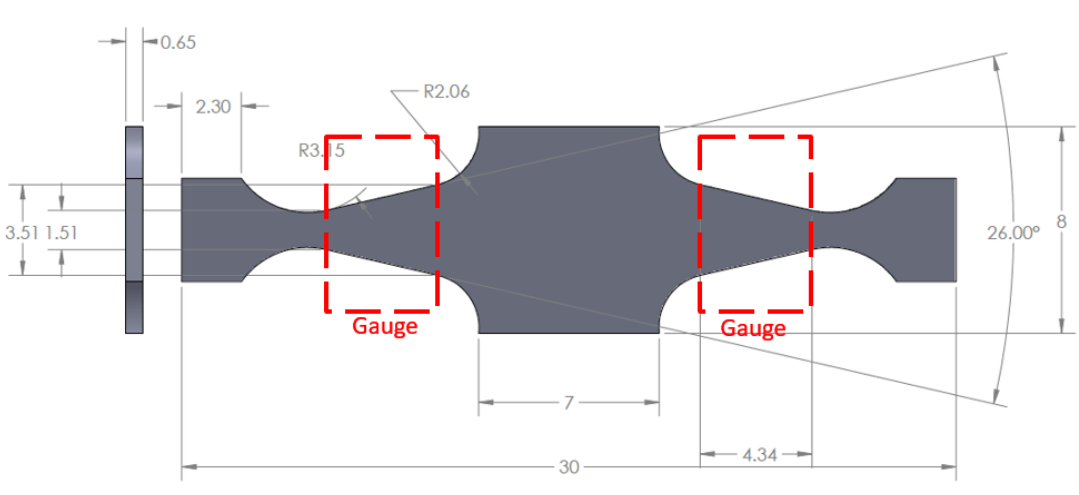
Figure 1. Drawing of the dual gauge section Krouse type mini specimen, all units are in